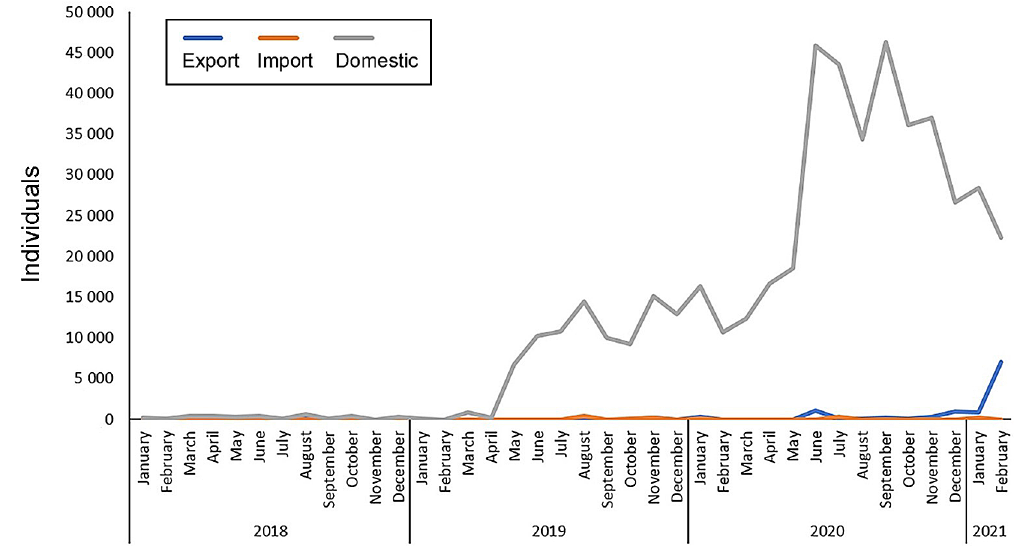
Fig. 1. Polypterus senegalus trade trend lines in Indonesia: individuals traded via export, import and domestic market per month from January 2018 to February